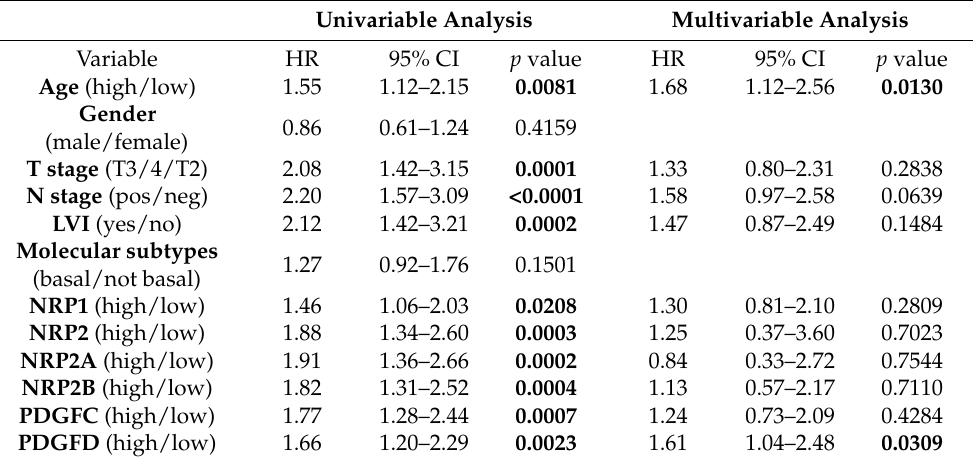
Figure 4. Kaplan–Meier curves of overall survival (OS) stratified by the mRNA expression of NRP2 and its transcripts ( A – C ), NRP1 ( D ) and PDGFC ( E ) and PDGFD ( F ). The cut-off values for high and low gene expressions were determined by a partition test with each group representing at least 20% of the total cohort. Significant p values are printed in bold. Table 4. Univariable and multivariable Cox regression analyses to test the effect of different parame- ters on overall survival in the TCGA